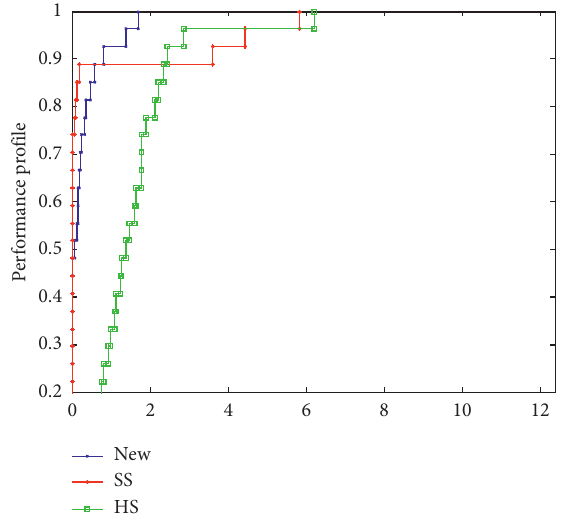
Figure 2: Performance profiles of the number of function